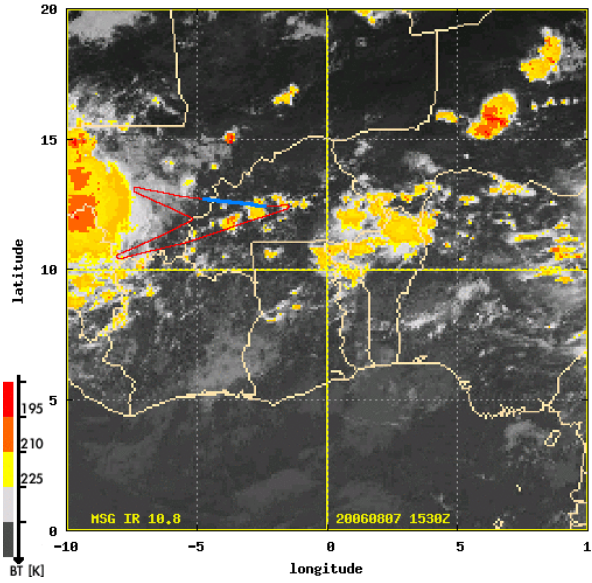
Fig. 2. Meteosat Second Generation (MSG) satellite image of Mesoscale Convective Systems (MCS) on 7 August 2006. The flight track of the M-55 Geophysica is indicated by the red/blue line. The blue part shows the flight segment of the time period for which the satellite image is valid and approximately where the mea- surements of Fig. 3 were